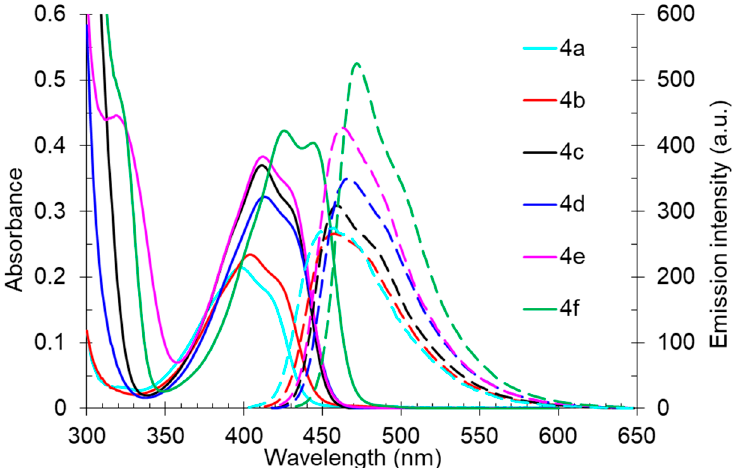
Figure 7. UV-vis absorption (5 × 10 − 5 M, solid lines) and emission (5 × 10 − 5 M, dashed lines) spectra of compound 4 in toluene.